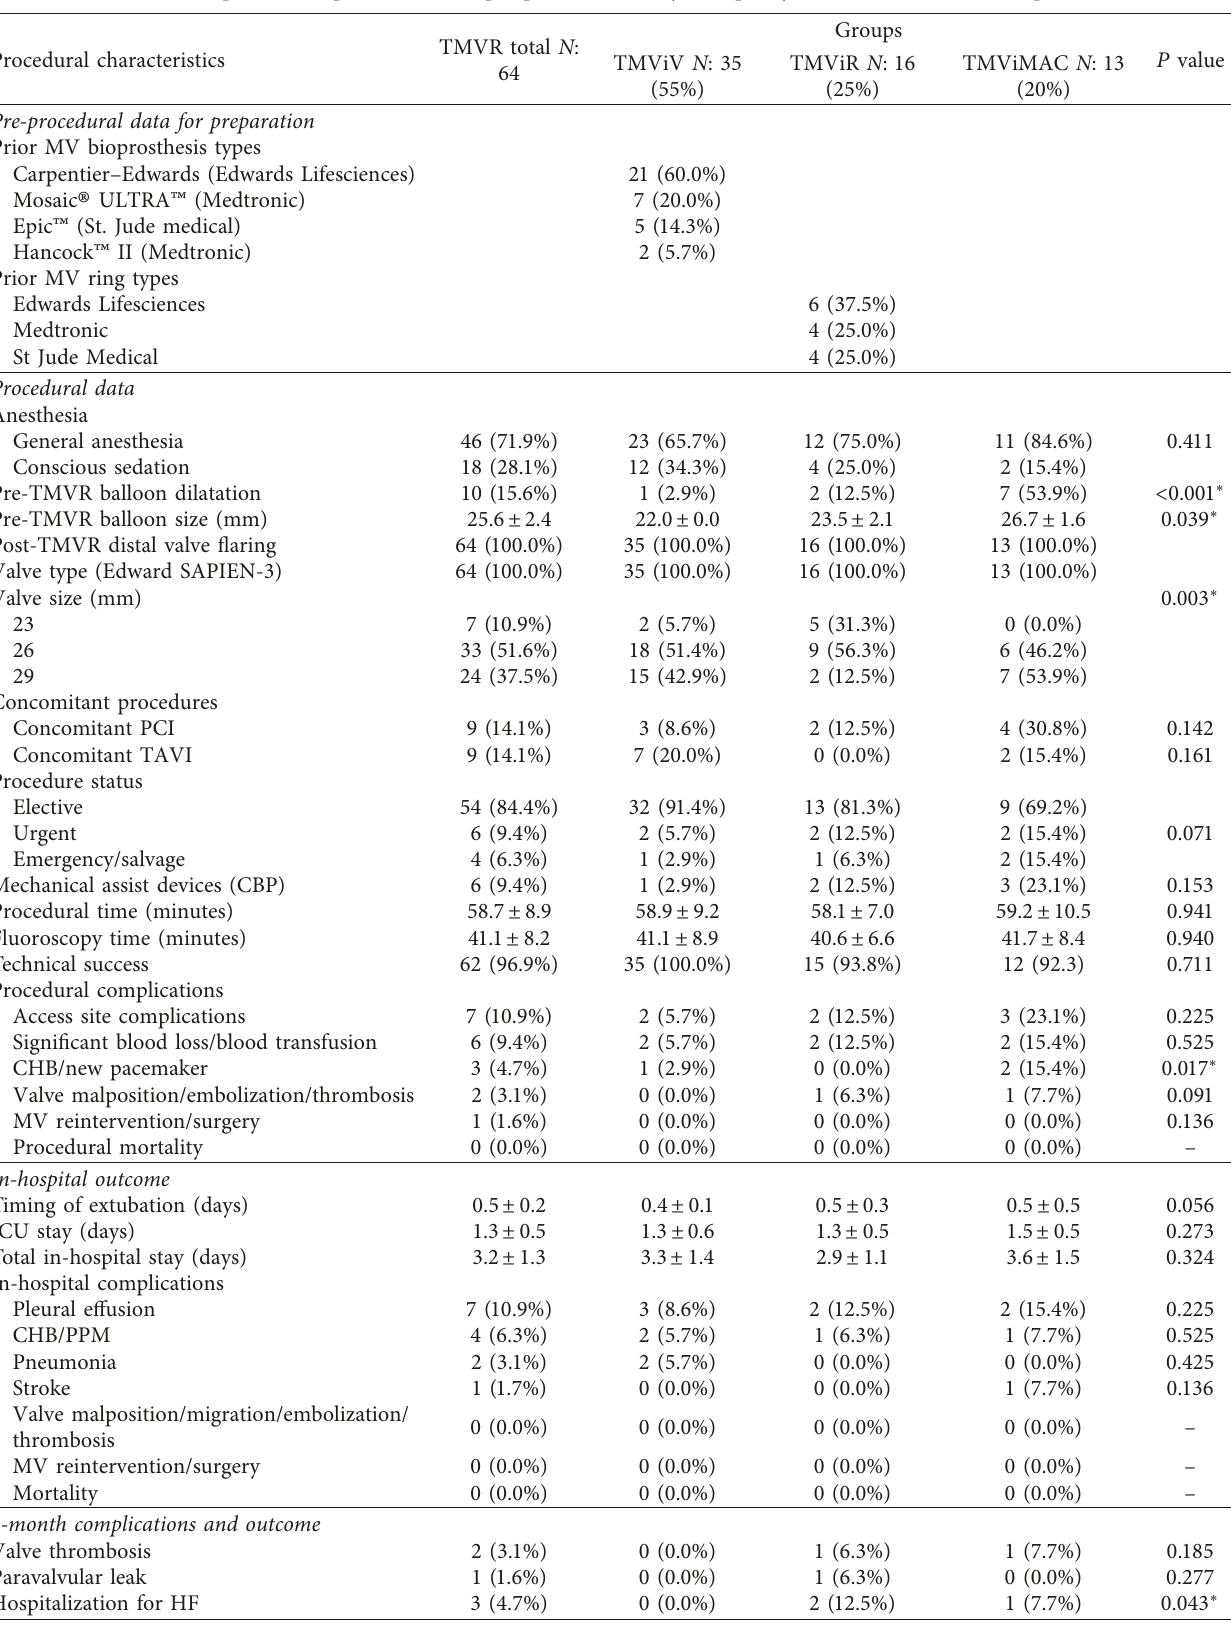
Table 2: Preprocedural, procedural, and postprocedural safety and quality measures for the studied